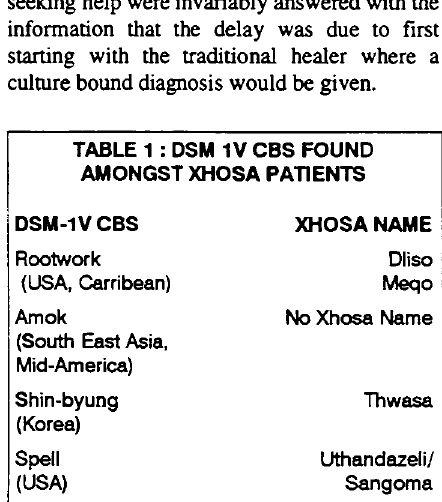
TABLE 1 : DSM IV CBS FOUND AMONGST XHOSA PATIENTS